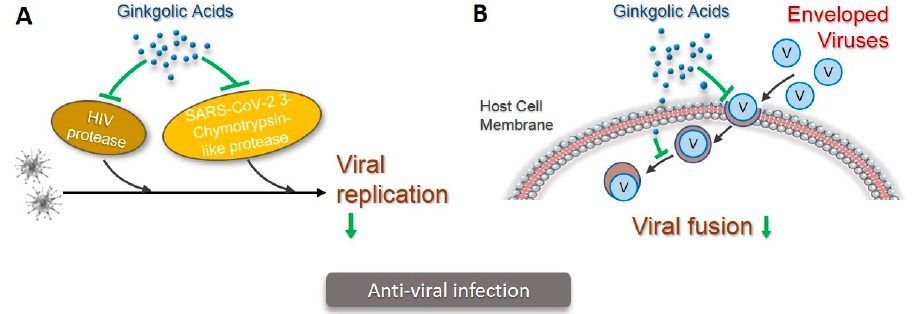
Figure 4. Mechanisms for anti-viral infection of ginkgolic acids. A. Ginkgolic acids inhibit the activity of HIV protease or SARS-CoV-2 3-Chymotrypsin-like protease, leading to inhibition of viral replication of HIV or multiple coronaviruses (illustrated in green). B. Ginkgolic acids inhibit viral fusion of a broad spectrum of enveloped viruses to host cell either on cell surface or intracellular compartments (illustrated in green).